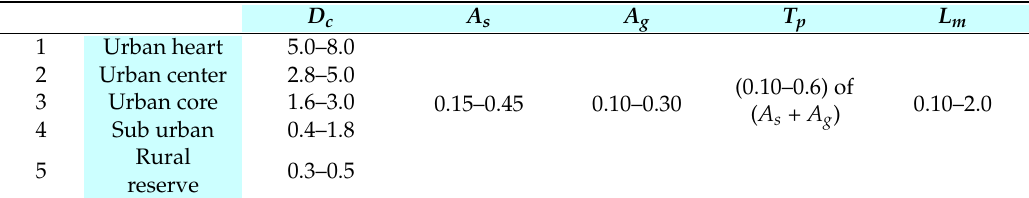
Table 4. Initial optimization ranges of UDCM parameters,